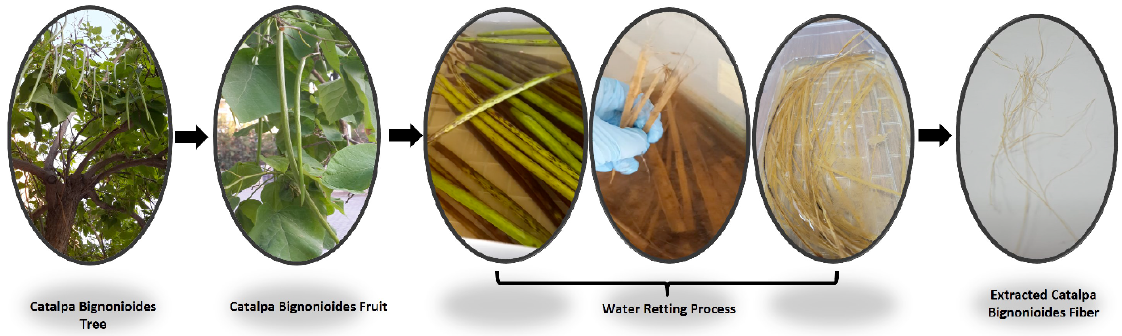
Figure 1. Catalpa bignonioides tree and